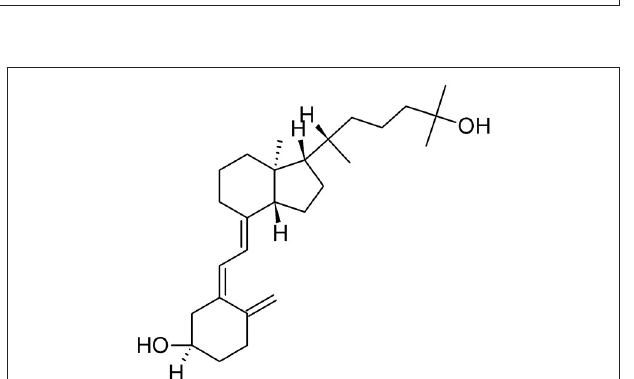
FIGURE 7 | Structure formula of 25-hydroxyvitamin D 3 .